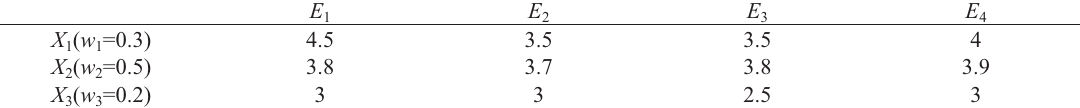
Table 8. The integrated decision matrix 1 R using NVs